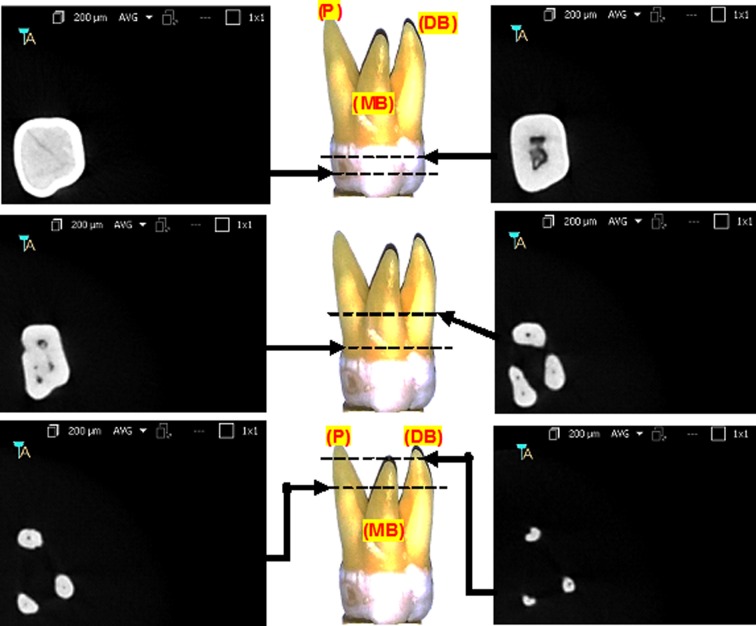
Internal anatomy of a typical maxillary 1st molar (three roots) using CBCT at various anatomical levels.